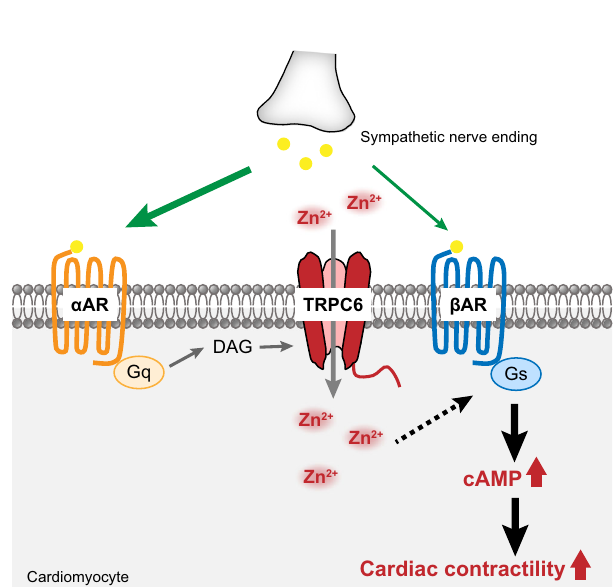
Fig. 7 | Schema of the role of TRPC6-mediated Zn 2+ in fl ux in adrenergic receptor-stimulatedcardiacinotropy. Cardiacinotropythroughthesympathetic nervous system has been considered to be predominantly mediated by β AR acti- vation,althoughthechemicalbindingaf fi nityofNEto β ARismuchlowerthanthat to α AR. This study demonstrates that α AR-mediated Zn 2+ in fl ux via TRPC6 pro- motes NE-induced cardiac inotropy by local Zn 2+ -dependent enhancement of β AR- G s signaling. Downregulation of the α AR-TRPC6-Zn 2+ axis may reduce sympathetic nerve – mediated cardiac